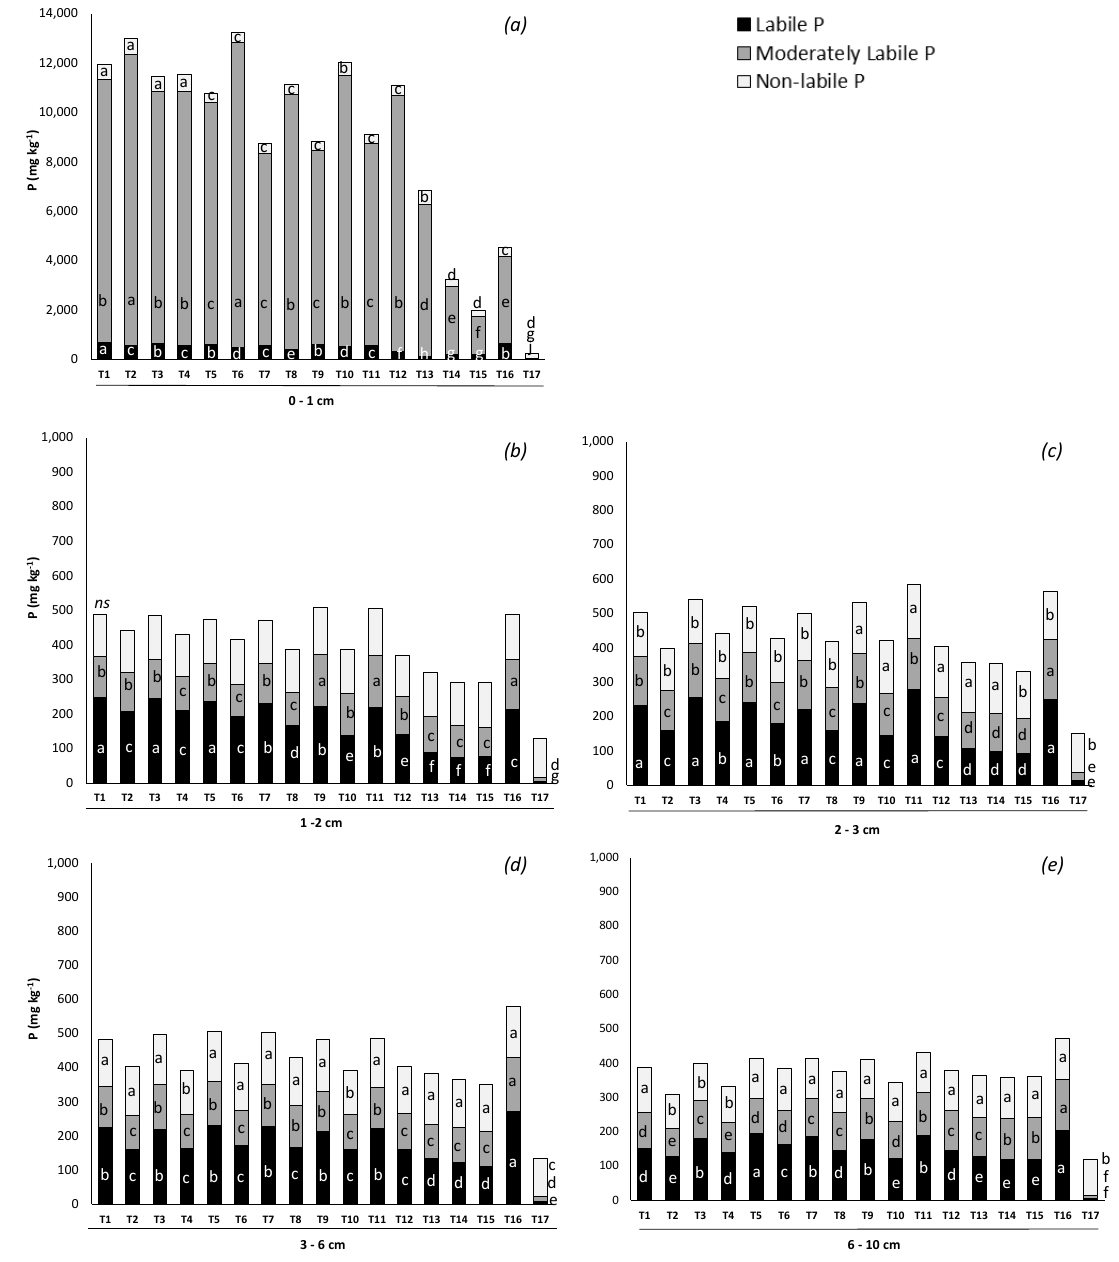
Figure 6. Labile, moderately labile and non-labile P pools in different soil layers of the column, 0–1 ( a ), 1–2 ( b ), 2–3 ( c ), 3–6 ( d ) and 6–10 cm ( e ), in response to phosphate fertilizers application after 60 days. Mean values followed by the same letter do not differ by t -test (Scott–Knott, P < 0.05). ns, not significant. T1 = ARP + PILC + 50% Ac.; T2 = ARP + PILC + 25% Ac; T3 = ARP + Zeo + 50% Ac; T4 = ARP + Zeo + 25% Ac.; T5 = BRP + PILC + 50% Ac.; T6 = BRP + PILC + 25% Ac.; T7 = BRP + Zeo + 50% Ac; T8 = BRP + Zeo + 25% Ac; T9 = MRP + PILC + 50% Ac.; T10 = MRP + PILC + 25% Ac.; T11 = MRP + Zeo + 50% Ac.; T12 = MRP + Zeo + 25% Ac.; T13 = ARP (Araxá rock phosphate); T14 = BRP (Bayovar rock phosphate); T15 = MRP (Morocco rock phosphate); T16 = TSP (triple superphosphate); T17 = control. PILC = pillared clay; Zeo = zeolite.